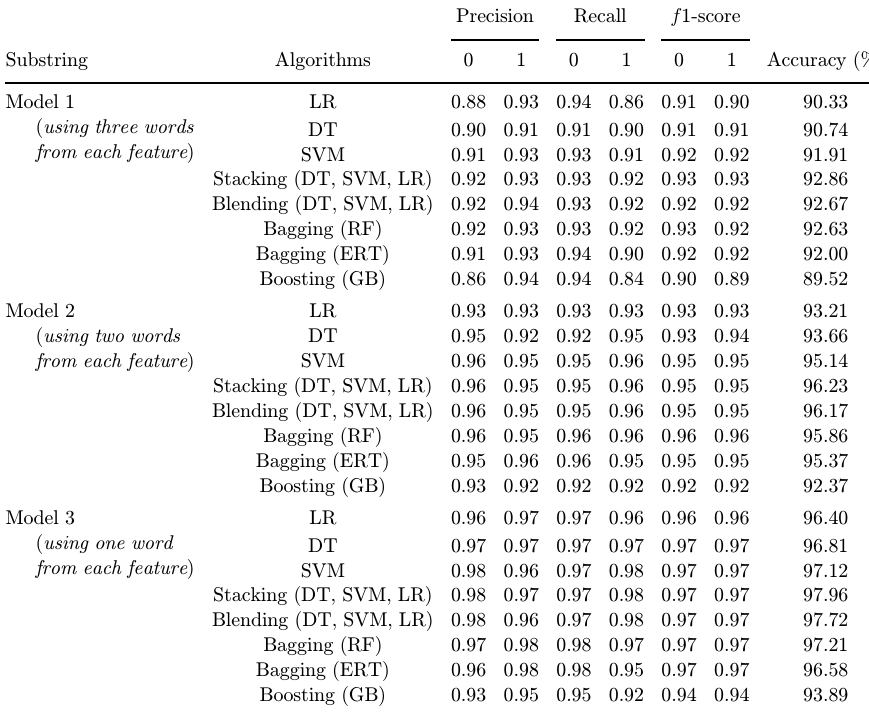
Table 4. Performance results after applying SBFS. Precision Recall f 1-score Substring Algorithms Model 1 ( using three words